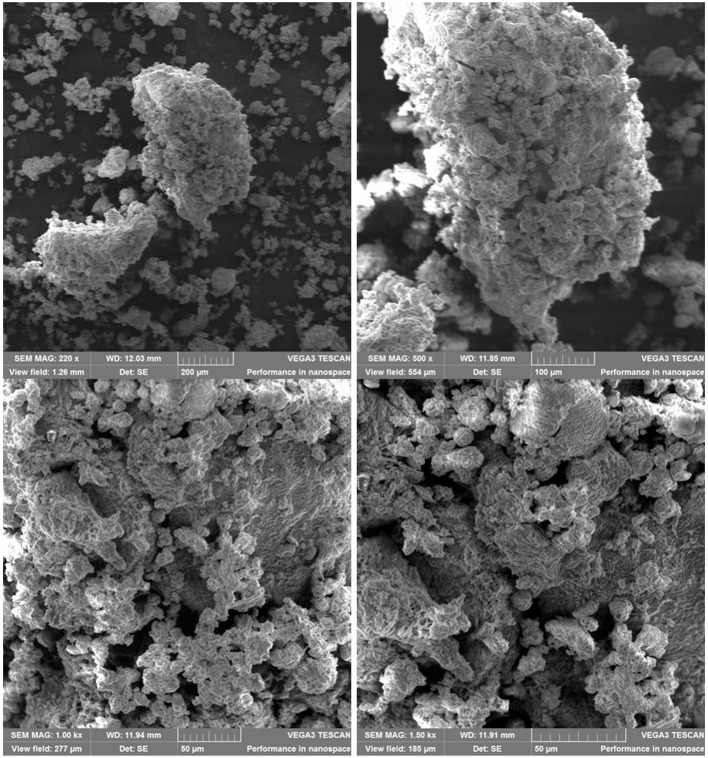
Aspect of structures from sample PU_0 at different magnifications.